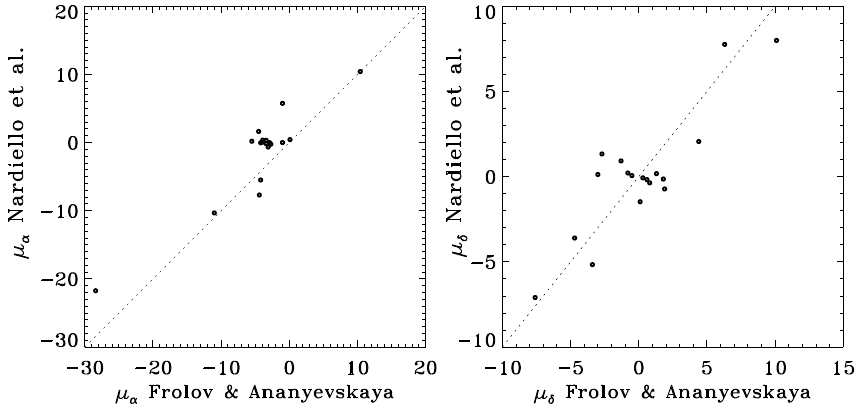
Fig. 2. Comparison of proper motions (in mas yr − 1 ) for the group members common to the catalogs of Frolov & Ananyevskaya (1986) and Nardiello et al. (2015).